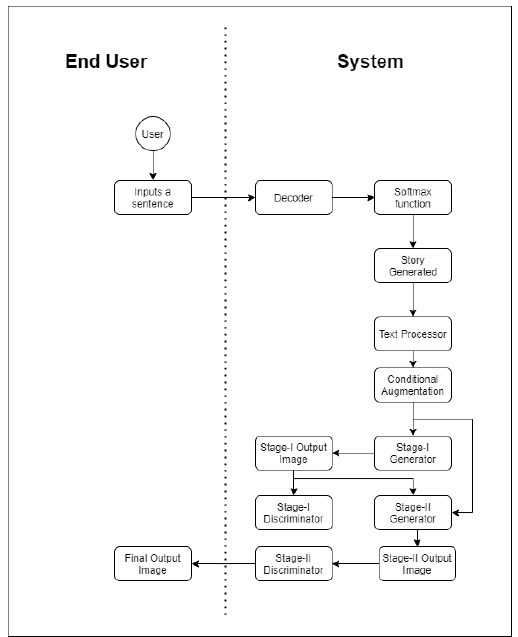
Fig. 3.2. Illustration of system flow.